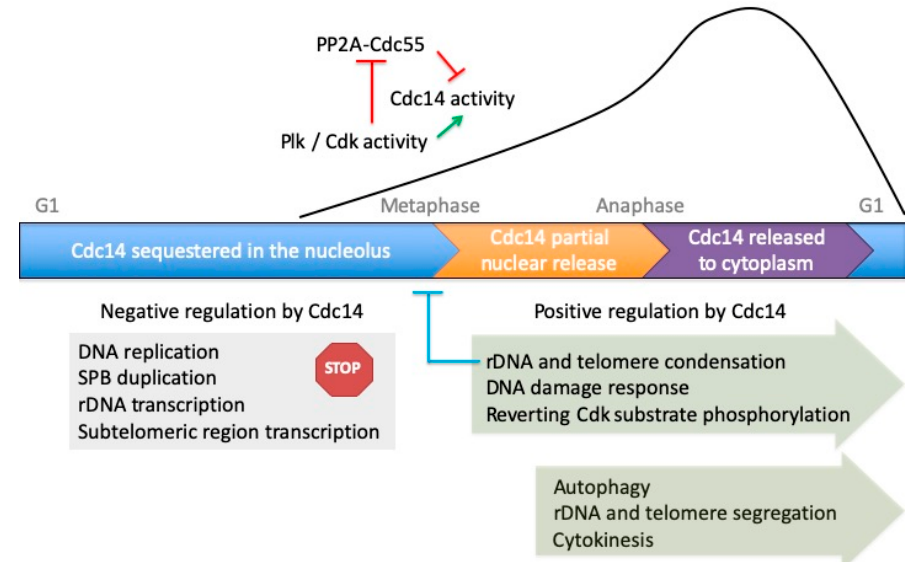
Figure 1. Cdc14 phosphatase is sequestered into the nucleolus through binding to Net1 / Cfi1 [6]. While inactive in this cellular compartment, Cdc14 cannot initiate DNA and spindle pole body (SPB) reduplication cycles [27,28,43,44], and the phosphorylated state of the RNA polymerases that preserve the transcriptional activity of sub-telomeric and ribosomal DNA (rDNA) regions can be maintained [34]. At the metaphase-to-anaphase transition, FEAR together with Plk and Cdk downregulate PP2A-Cdc55 (inhibitory red line) and trigger Net1 / Cfi1 phosphorylation to promote the first releasing wave of Cdc14 into the nucleus (green arrow) [45,46]. Once at this location, Cdc14 activity (black line) progressively downregulates cyclin-dependent kinase (Cdk) phosphorylation, thereby promoting rDNA and telomere condensation through RNA polymerase I and II inhibition to facilitate the segregation of these chromosomal regions [33,34,47,48] and also priming the activation of the mitotic exit network (MEN) pathway [49,50]. Nucleolar hyper-condensation blocks e ffi cient Cdc14 release (inhibitory blue line) [32]. Cdc14 further participates in the DNA damage response by anchoring DNA lesions to the SPBs, in this way facilitating their repair [51]. In anaphase, Cdc55 phosphorylation by Cdk1-Clb2 stimulates full Net1 / Cfi1 and Cdc14 disassociation and, subsequently, completes Cdc14 activation (inhibitory red line) [52]. The final release of Cdc14 to the cytoplasm globally reverses Cdk activity in coordination with PPA2-Cdc55 and PPA2-Rts1 phosphatases, supporting exit from mitosis [53]. Excitingly, Cdc14 also works as a central hub that coordinates mitotic progression with signaling pathways such as high-osmolarity glycerol (HOG) or target of rapamycin complex 1 (TORC1) [54–56]. Notably, however, Cdc14 functions are not restricted to cell cycle regulation, as the phosphatase can also induce autophagy under starvation stress